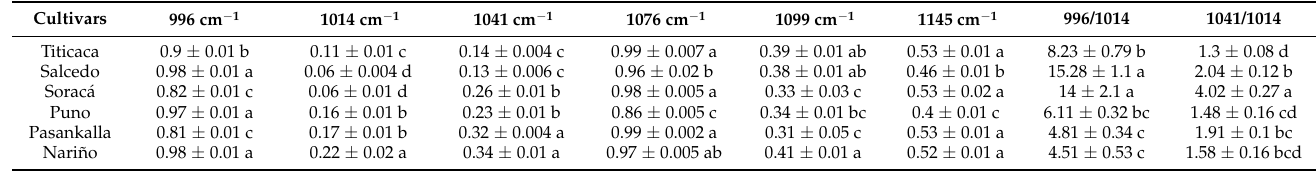
Table 4. Band intensities of starch from different Colombian quinoa cultivars. Cultivars